Question: State the chart type depicted above.
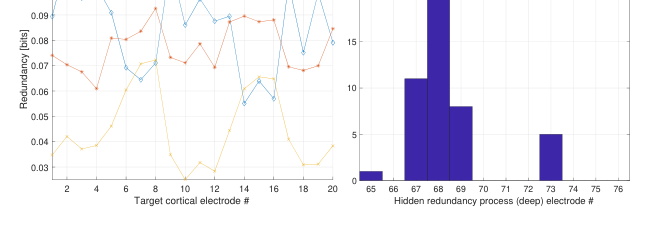
Answer: histogram